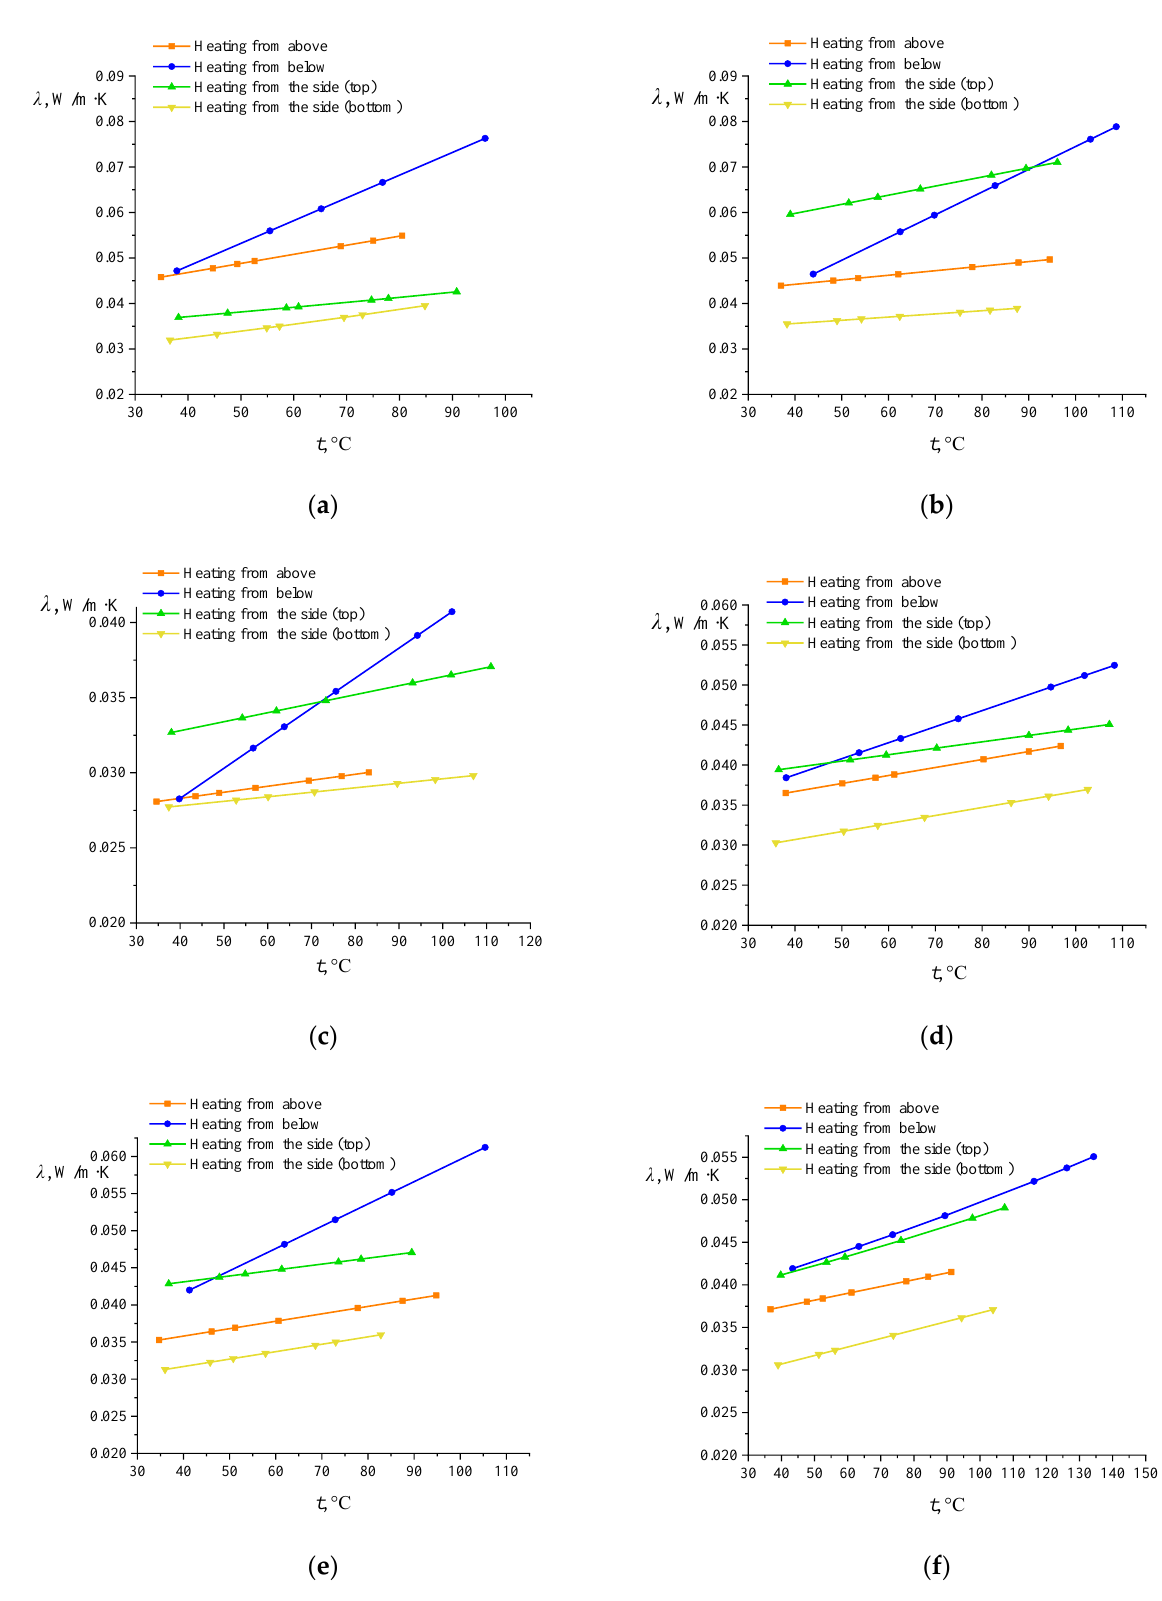
Figure 8. Graphs of changes in the effective thermal conductivity of PUF at different positions of the heater: ( a ) closed-cell foam, d = 6.28 mm; ( b ) open-cell foam, d = 3.1 mm; ( c ) open-cell foam, d = 0.725 mm; ( d ) mixed-cell foam, d = 3.28 mm; ( e ) mixed-cell foam, d = 3.4 mm; ( f ) mixed-cell foam, d 1 = 0.7 mm and d 1 = 2.523